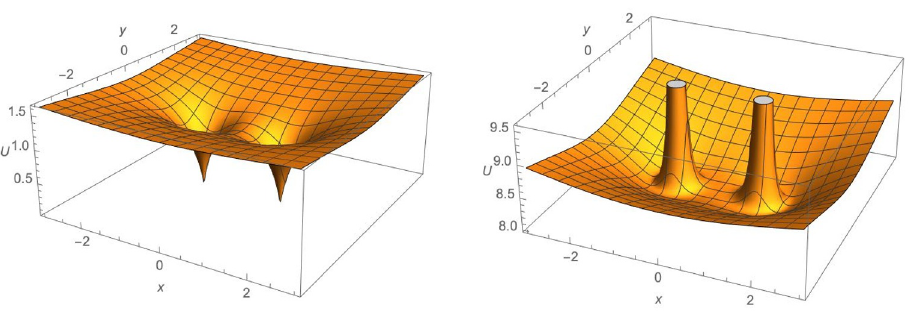
Figure 2 . The potential energy function (3.26) in the plane z = 0 with defects at ~ν 1 = ( − 1 , 0 , 0) and ~ν = (1 , 0 , 0) . (Here and in the following we use ( x, y, z ) to denote the Cartesian components 2 of ~ R .) The left plot has C = 1 and q = 0 . The right plot has C = 2 and q = 1 . If | q | > | C | there is no trough in which to contain bound